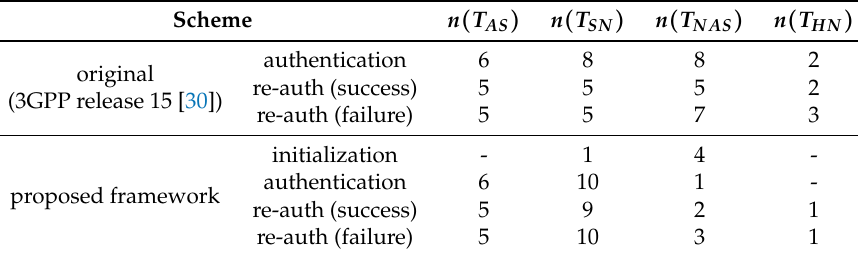
Table 4. Number of packets on Each Communication.